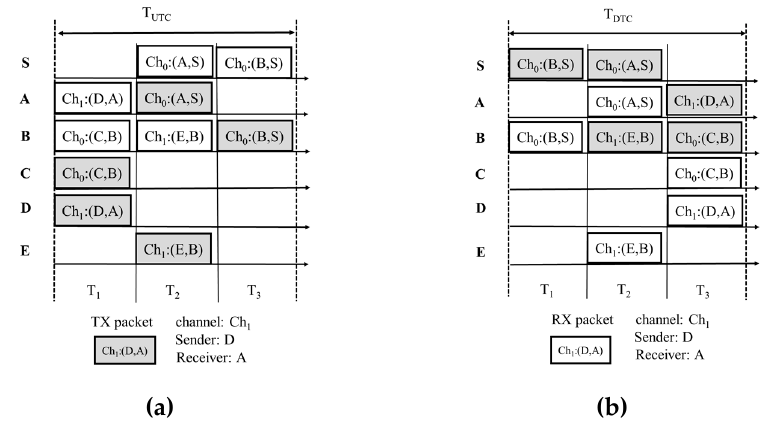
Figure 10. Data transmission after receiving the REDUCE command packet. ( a ) Data transmission in UTC; ( b ) Data transmission in UTC.